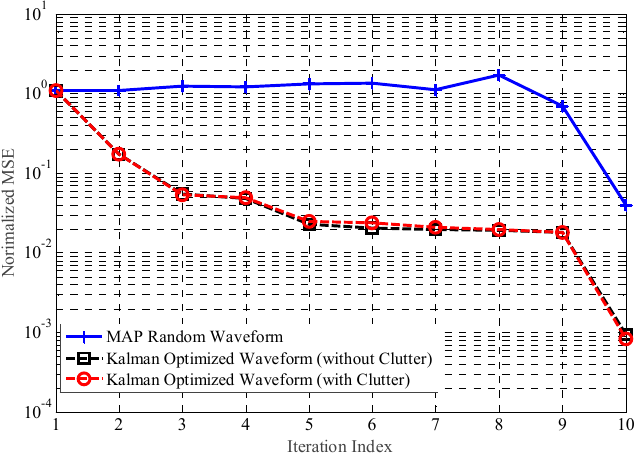
Figure 3. The estimation performance without the interference.